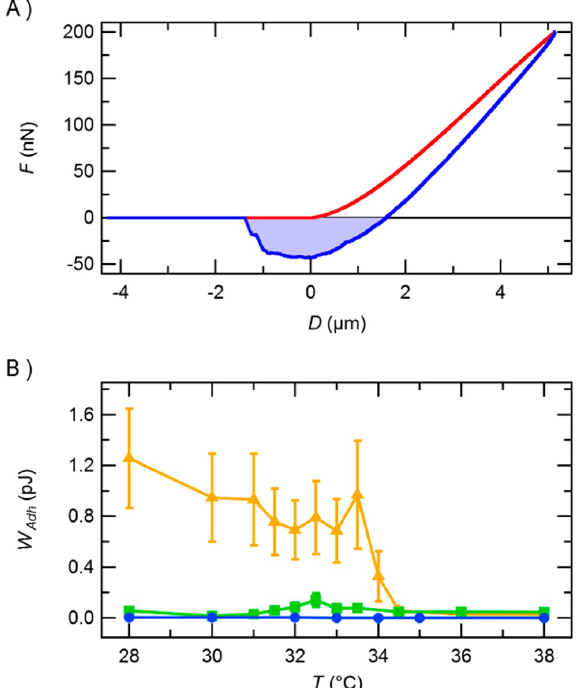
Figure 10. ( A ) Force curve during approach (red) and retraction (blue). The light blue area represents the work of adhesion; ( B ) Temperature-dependent work of adhesion for plain PAAM (blue circles), plain PNIPAM (orange triangles), and PNIPAM-PAAM core-shell (green squares) microgels. Taken from